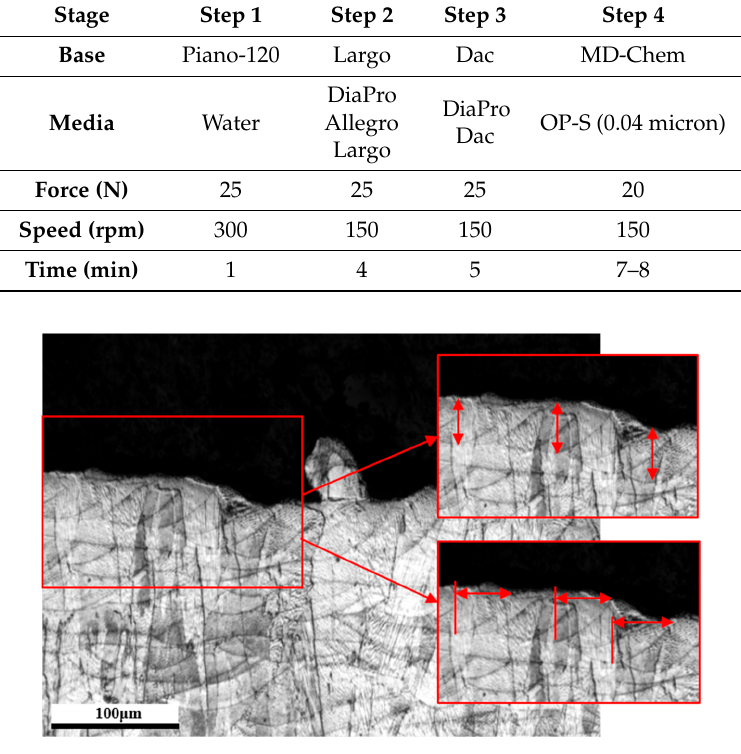
Figure 1. Experimental procedure for melt track measurements for both height and width.